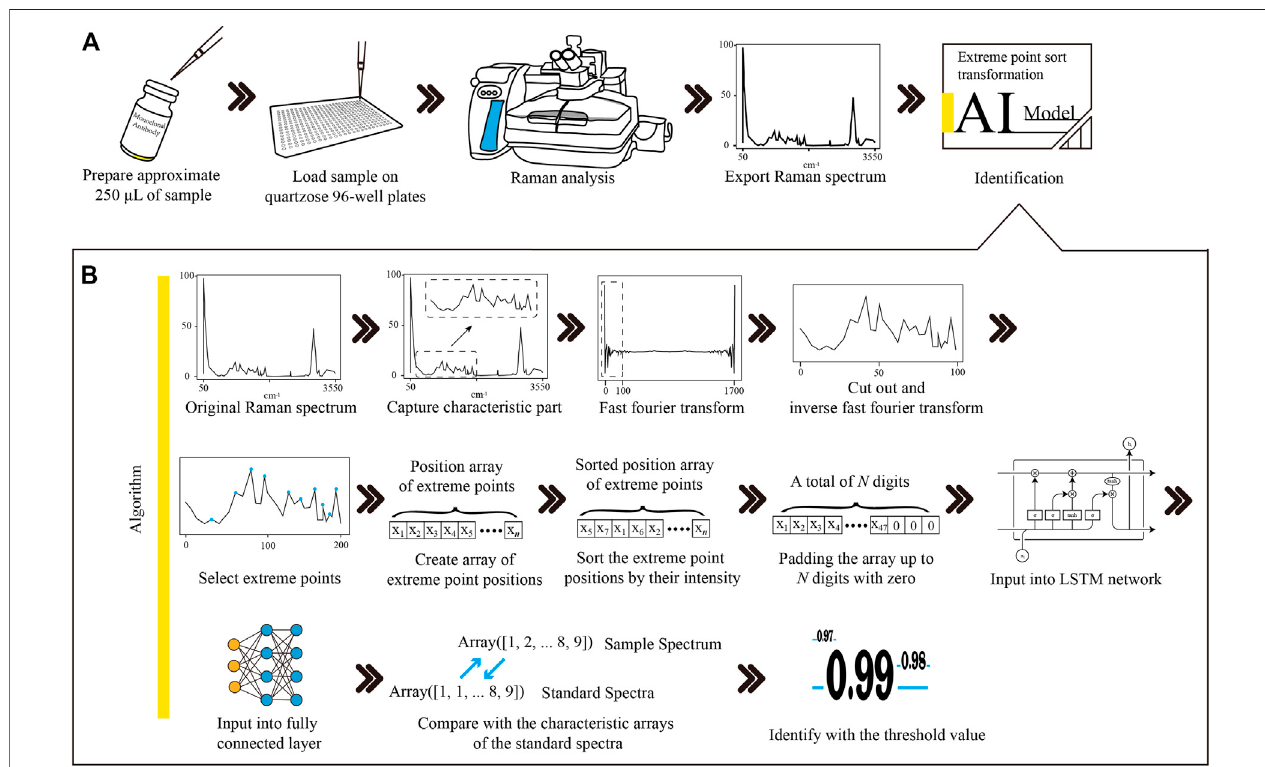
FIGURE 1 | The work fl ow of Raman-based therapeutic mAb identi fi cation and the procedures of Raman spectrum transformation combined with LSTM network modelling. (A) ThetherapeuticmAbsamplewasloadedintoaquartzose96-wellplate.RamananalysiswasperformedtoobtaintheRamanspectrumofthesample.The Ramanspectrumwasexported intotheCSV fi leandtheninputintotheLSTM networkmodelforidenti fi cation. (B) ThecharacteristicregionoftheRamanspectrumwas extracted from the original spectrum. The noises of the characteristic region were removed, and the dimension was reduced with FFT and IFFT fi ltering. The positions of the extreme points were picked up and then sorted by the intensity ofeach point to create an array. The array was padded up to N digits with zero to satisfy therequirementoftheinputlayeroftheLSTMnetworkmodel. TheLSTM layersequentiallyconnectedtotheFCLformed thehiddenlayersofthemodel. Thesimilarity of the sample spectrum and the standard spectrum was calculated by comparing their outputs from the FCL. The sample was identi fi ed as the therapeutic mAb, and the similarity value was higher than the threshold. mAb, monoclonal antibody; LSTM, long short-term memory; CSV, comma separated value; FFT, fast Fourier transformation; IFFT, inverse fast Fourier transformation; FCL, fully connected